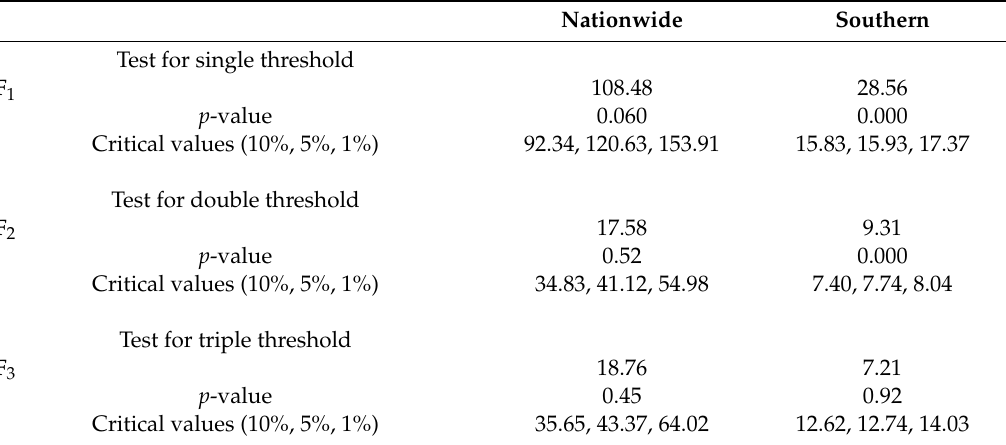
Table 2. Tests for threshold e ff ects.